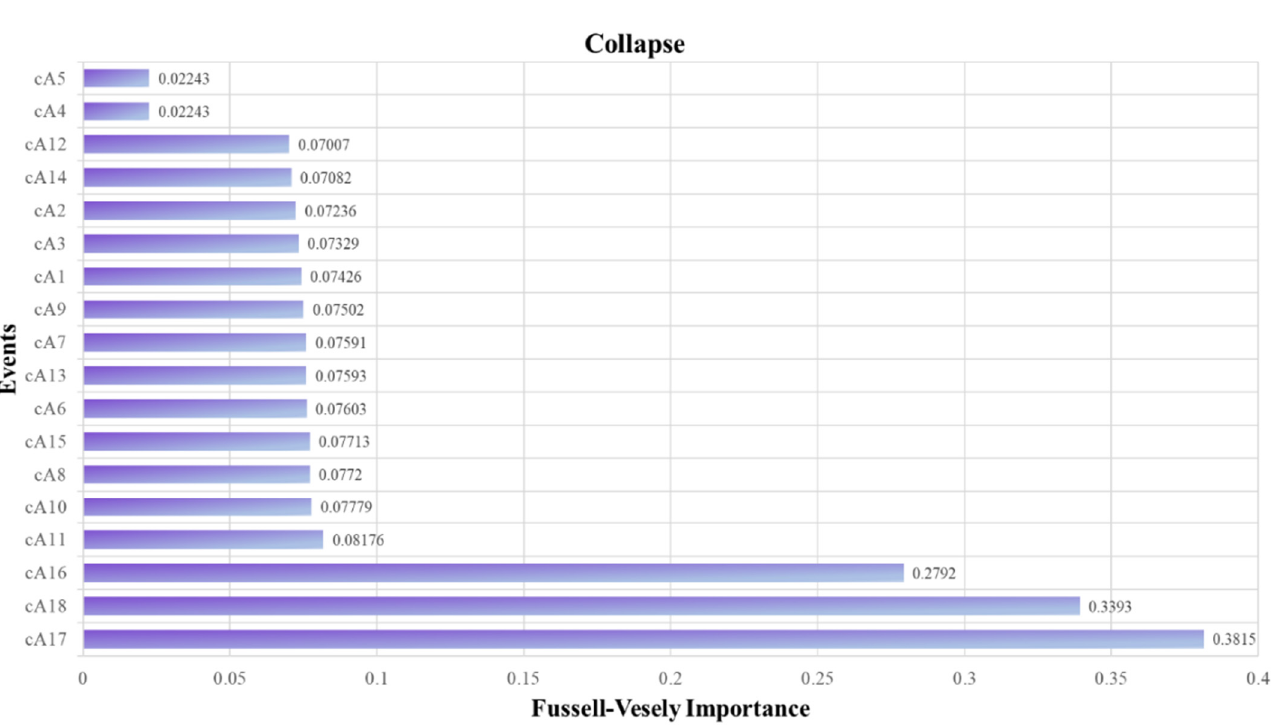
Figure 5. Fussell–Vesely Importance of each basic event of corrosion accident.